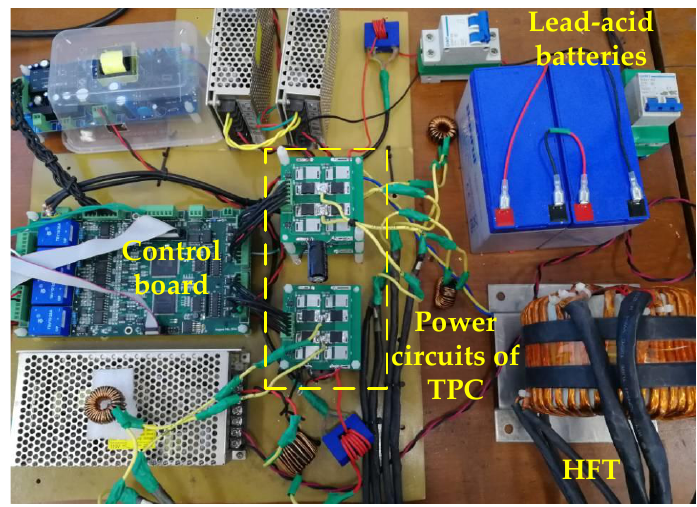
Figure 6. Hardware experiment circuit of the three-port converter.